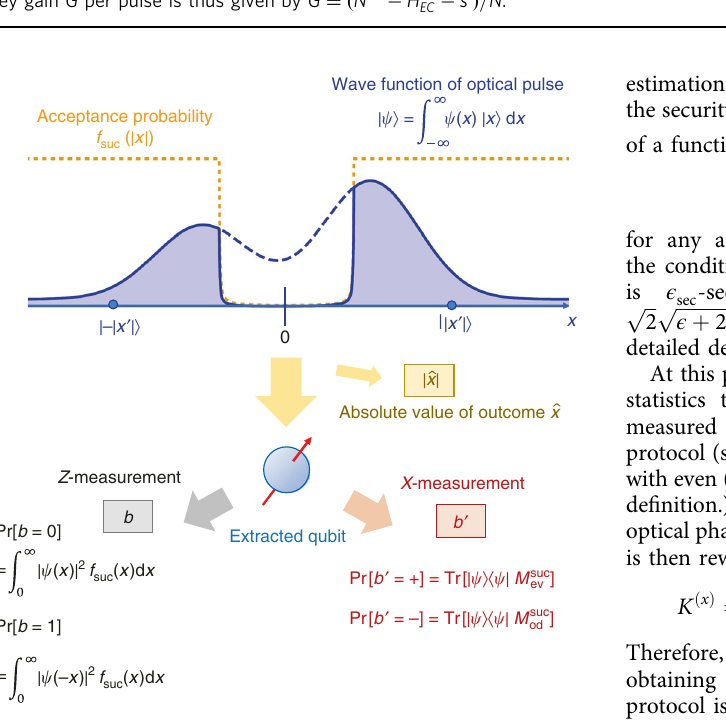
Fig. 3 Bob ’ s qubit extraction in the entanglement-sharing protocol.